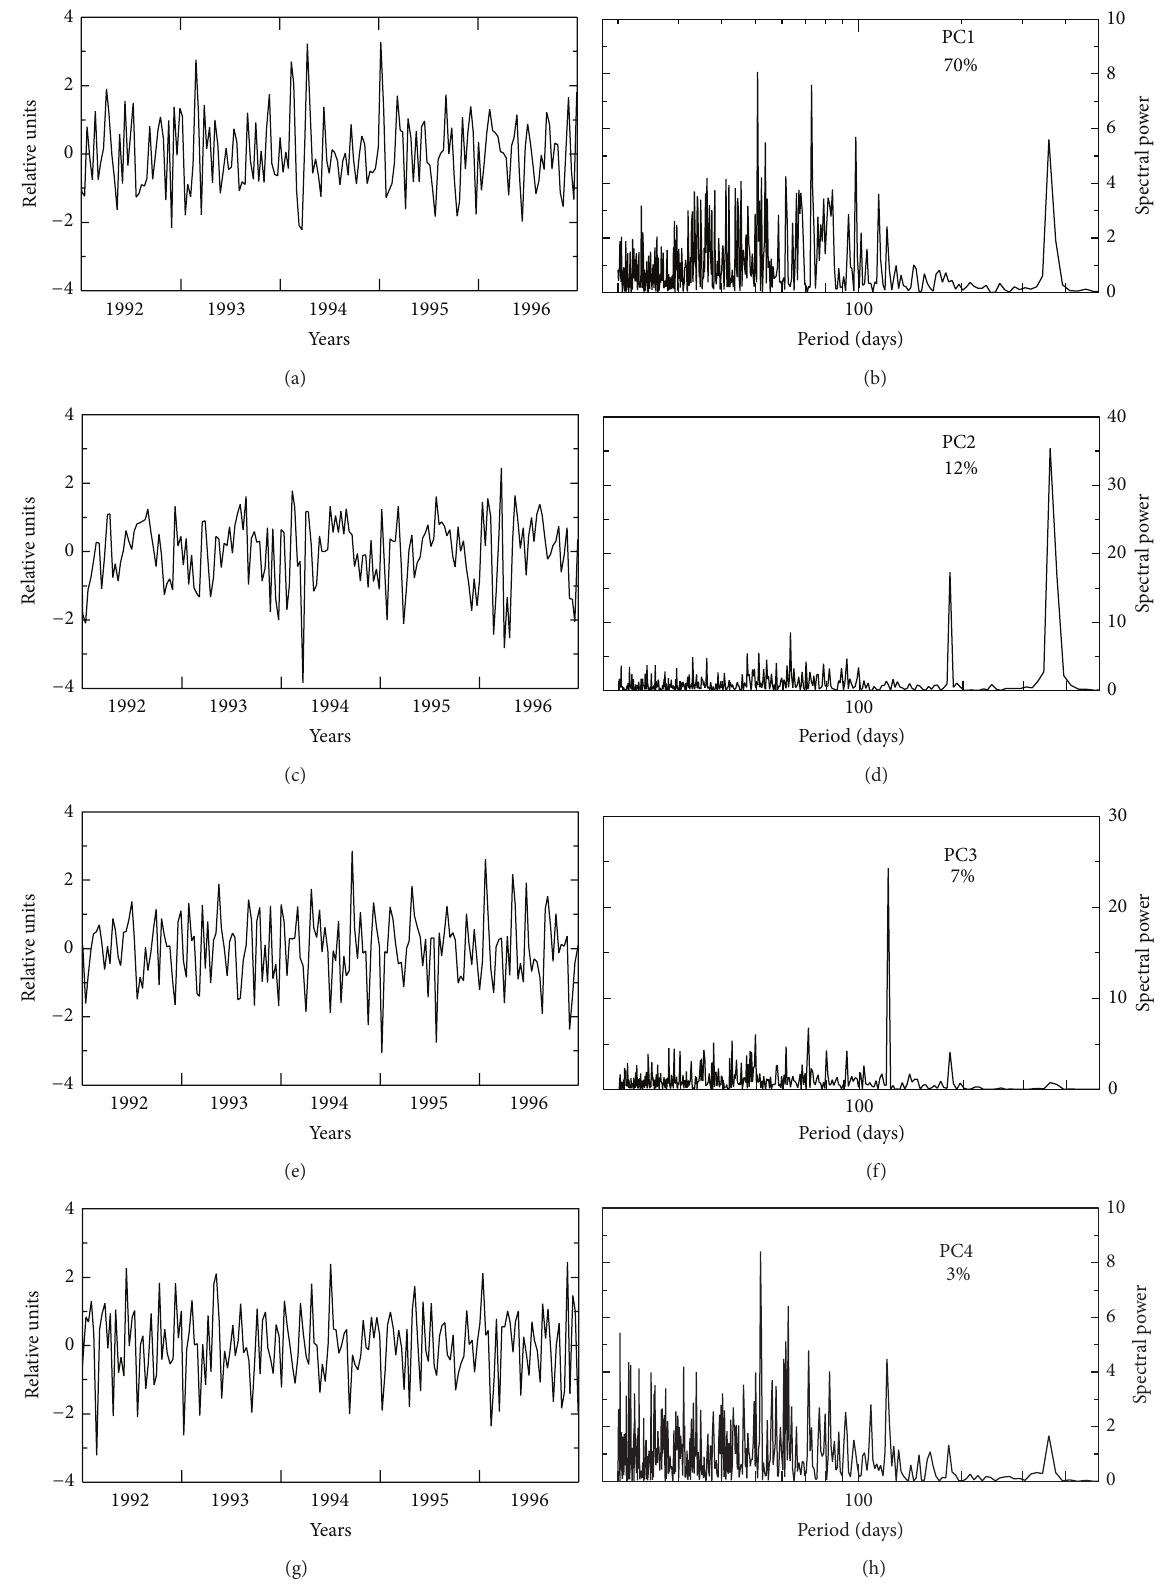
Figure 5: The leading four PCs presented for a 5-year period (left) that are associated with the corresponding EOFs found from the decomposition of matrix F 1 (see upper part of Figure 4) together with their spectra (right). The two panels of each row correspond to the same PC indicated on the right, together with its weight 𝑤 𝑗 in